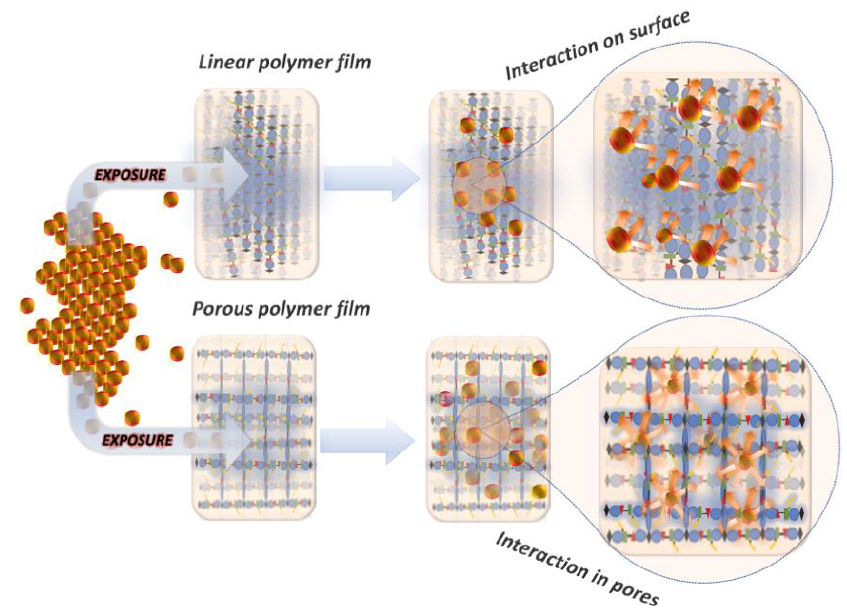
Figure 2. Illustration of the films formed from linear and porous polymers, and the comparison of their interaction with the guests or analytes after exposure.